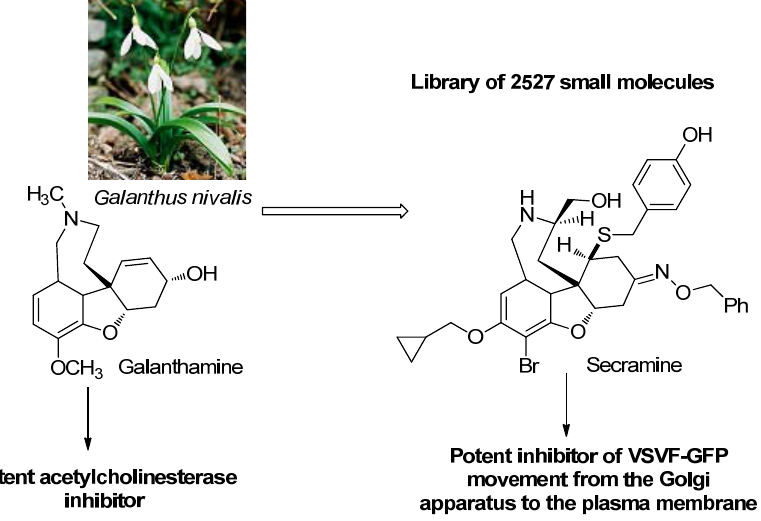
Figure 10. Development and discovery of VSVF-GFP inhibitor via BIOS